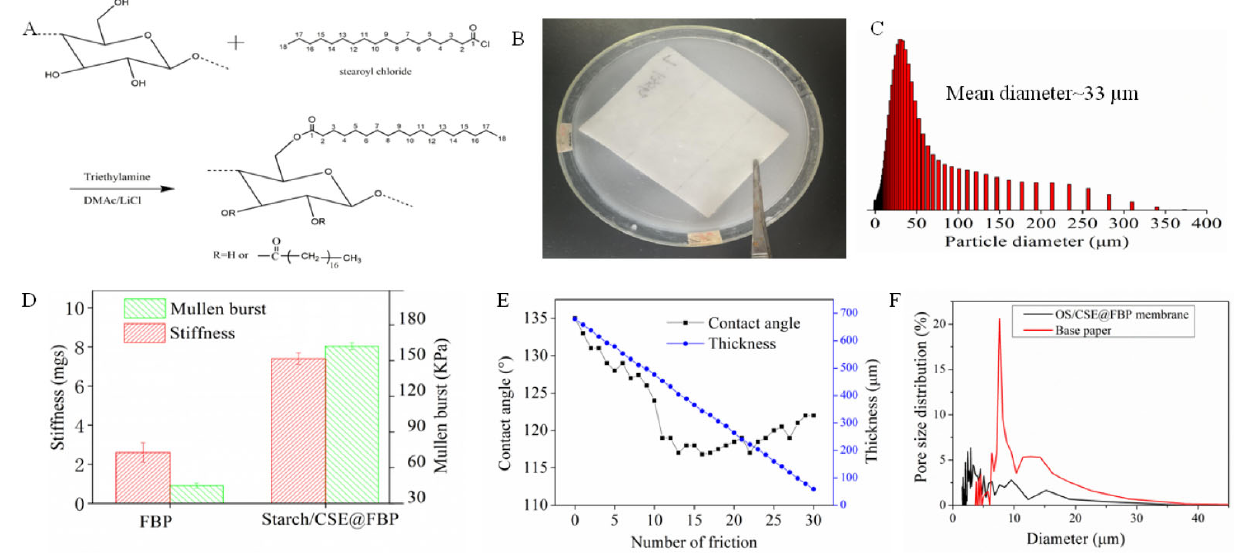
Figure 1. ( A ) synthesis route of CSE, ( B ) impregnation process of OS/CSE@FBP membrane, ( C ) particle size distribution of CSE, ( D ) stiffness and bursting strength of base paper, OS/CSE@FBP and ( E ) thickness and contact angle changes during friction, ( F ) pore size distribution of FBP and OS/CSE@FBP membrane.